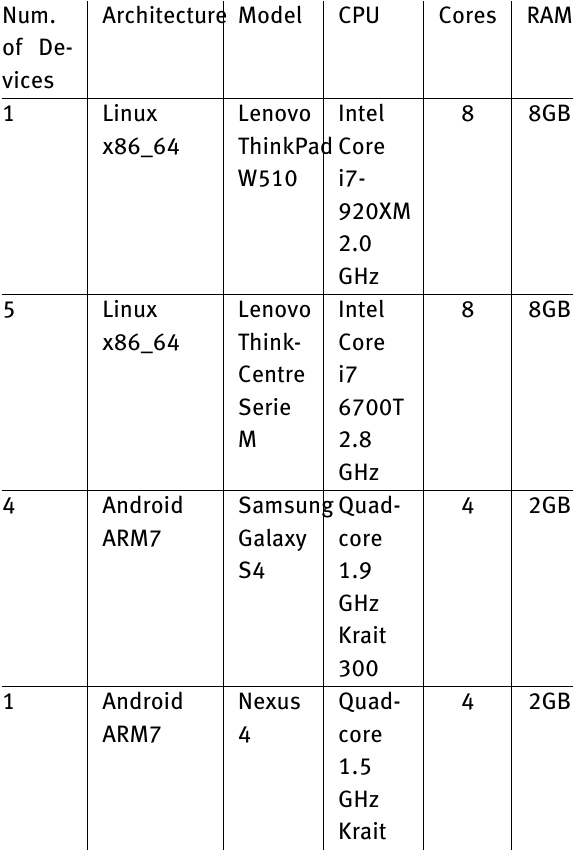
Table 1: Technical characteristics of the devices